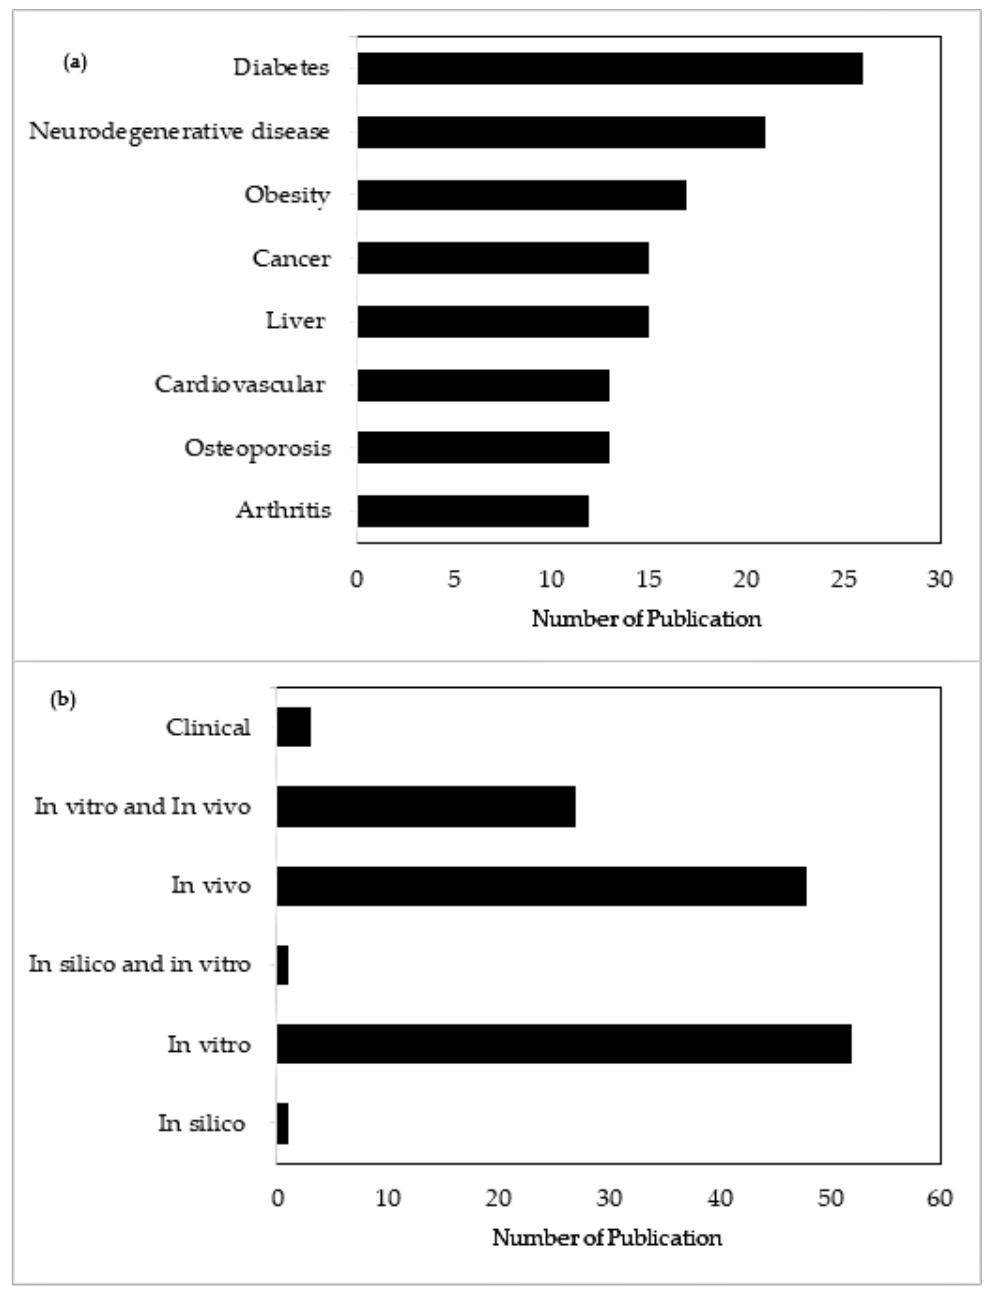
Figure 1. Number of publications on functional seaweed and chronic disease based on ( a ) the type of chronic disease and ( b ) the experimental